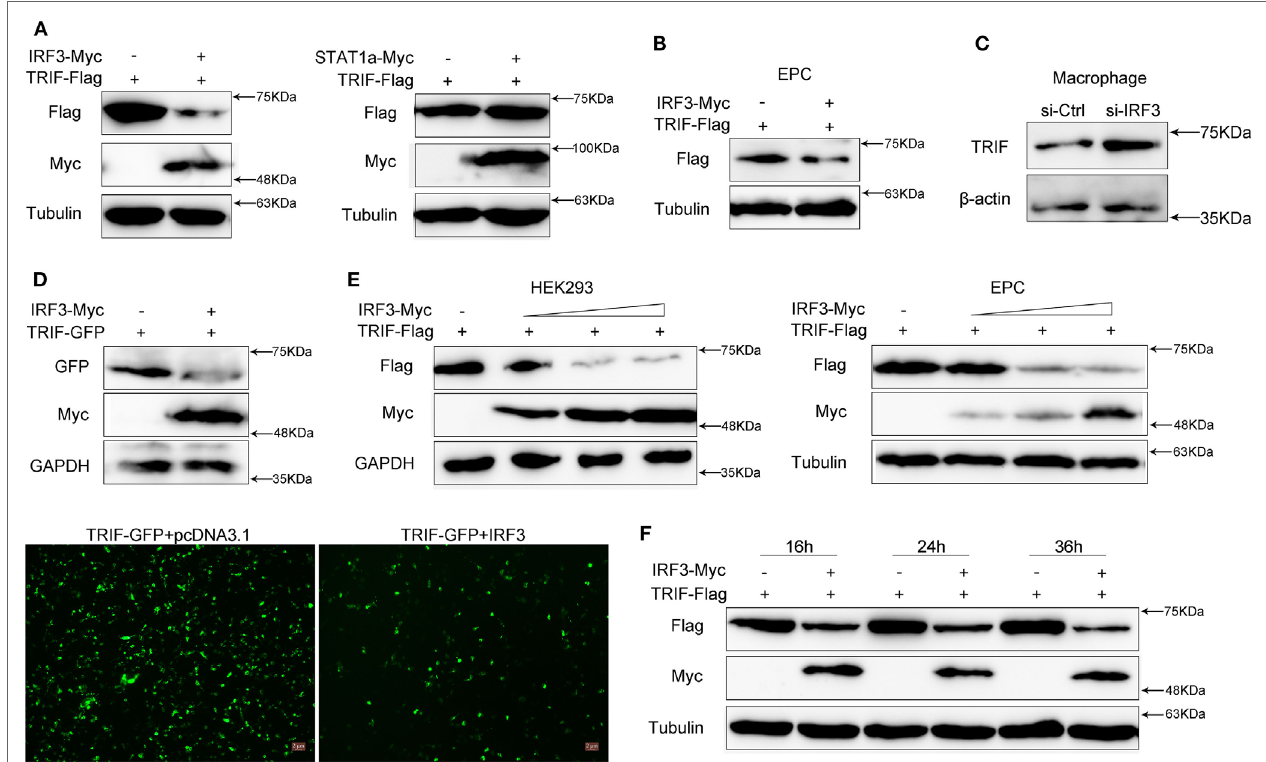
FigUre 4 | IRF3 promotes the TRIF degradation. (a) HEK293 cells were co-transfected with empty vector, IRF3 (left) or STAT1a (right) together with TRIF, after 48 h, TRIF protein levels were determined by immunoblot assays and normalized to tubulin. (B) EPC cells were co-transfected with empty vector or IRF3 together with TRIF, after 48 h, TRIF protein levels were determined by immunoblot assays and normalized to tubulin. (c) Miiuy croaker macrophages were transfected with the scrambled control RNA (si-Ctrl) or si-IRF3. After 48 h, TRIF protein levels were determined by Western blot and normalized to β -actin. (D) HEK293 cells were co-transfected with empty vector, IRF3 together with TRIF-GFP, after 48 h, the fluorescence signals of TRIF-GFP were detected by fluorescence microscopy (below), then TRIF protein levels were determined by immunoblot assays and normalized to GAPDH (top). (e) The concentration gradient experiment of IRF3 expression plasmid within TRIF was conducted in HEK293 (left) and EPC cells (right) respectively, TRIF protein levels were determined by immunoblot assays and normalized to GAPDH or tubulin. (F) The time gradient experiment of IRF3 expression plasmid within TRIF was conducted, TRIF protein levels were determined by immunoblot assays, and normalized to